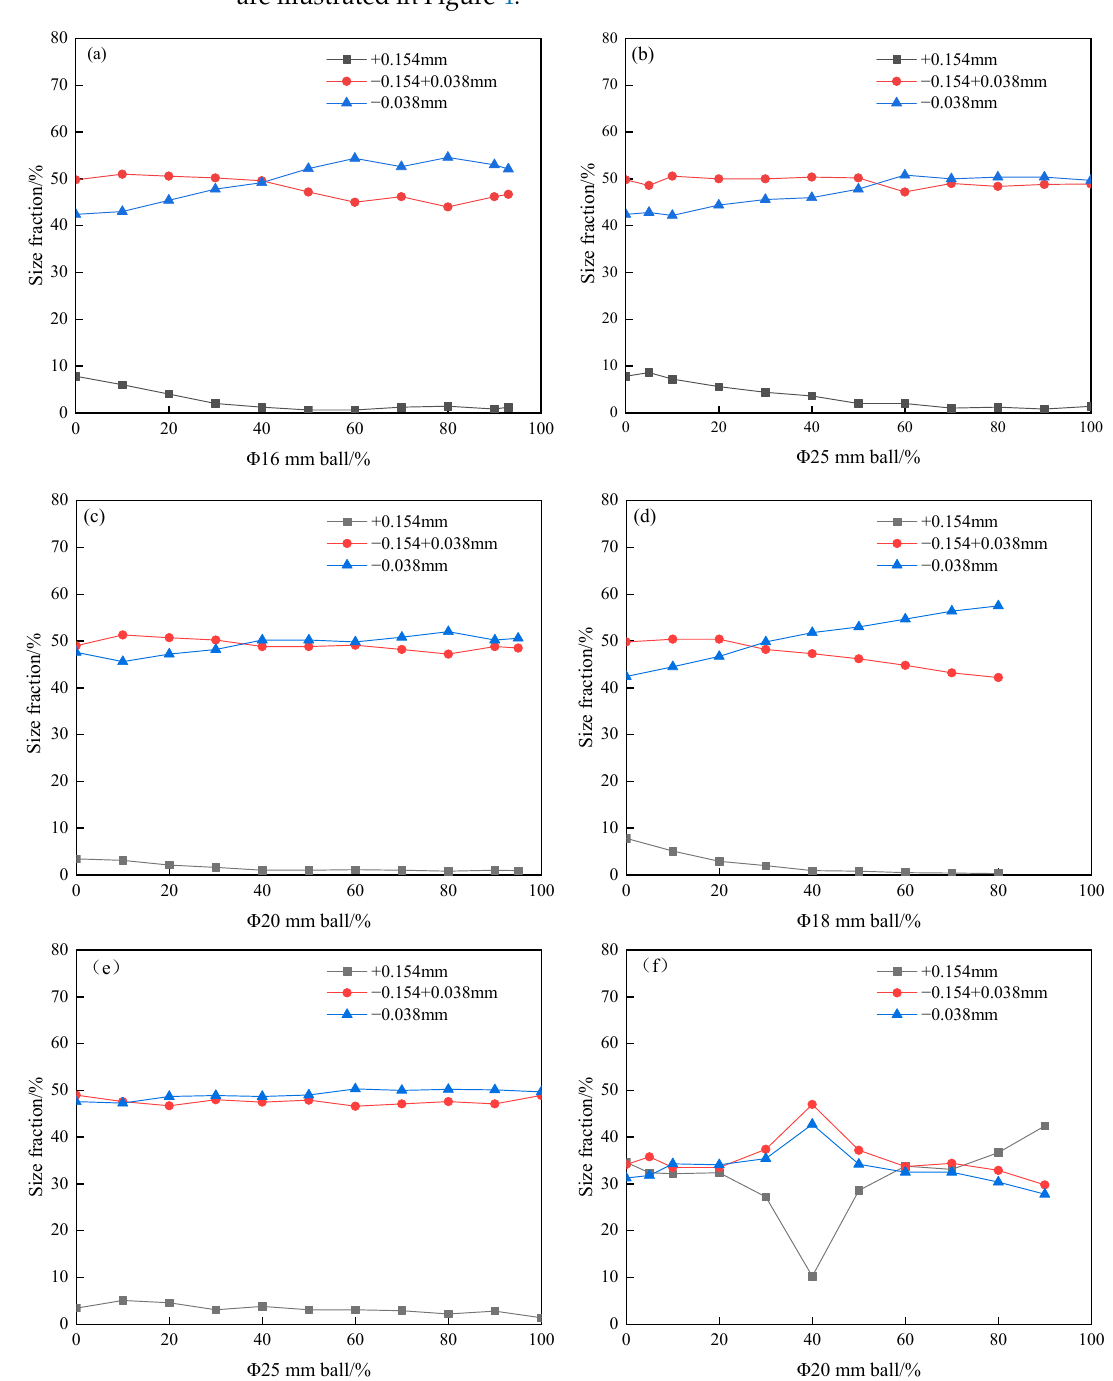
Figure 4. Grinding results with different ball mixture patterns: ( a ) 40 plus 16 mm balls, ( b ) 40 plus 25 mm balls, ( c ) 30 plus 20 mm balls, ( d ) 40 plus 18 mm balls, ( e ) 30 plus 25 mm balls, and ( f ) 20 plus 16 mm balls.